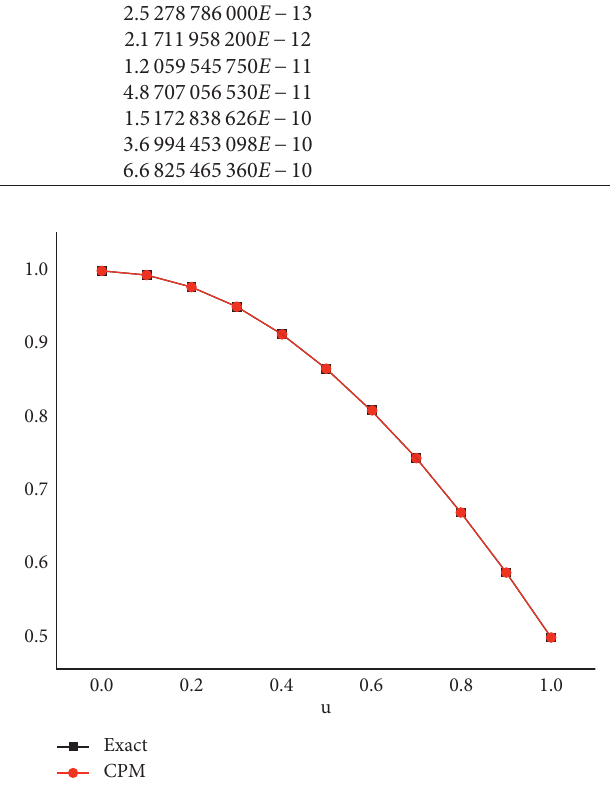
Figure 4: The graph of absolute error at various fractional orders for problem